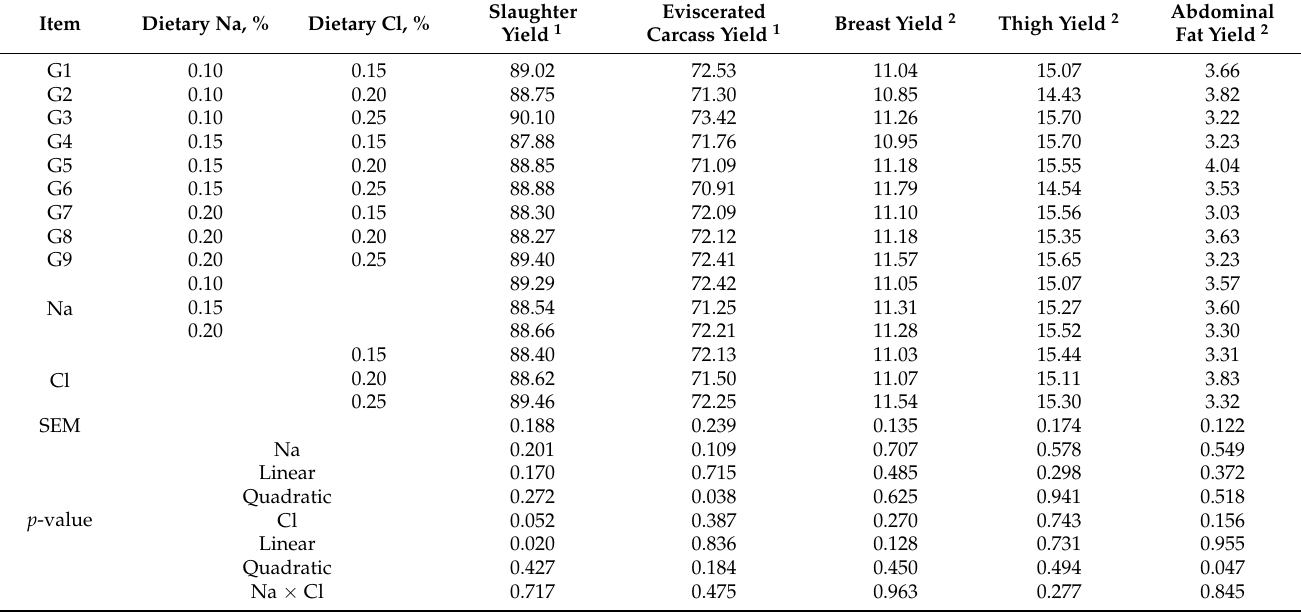
Table 2. Effects of dietary Na and Cl on slaughter performance (%) of 70-day-old geese ( n = 6).